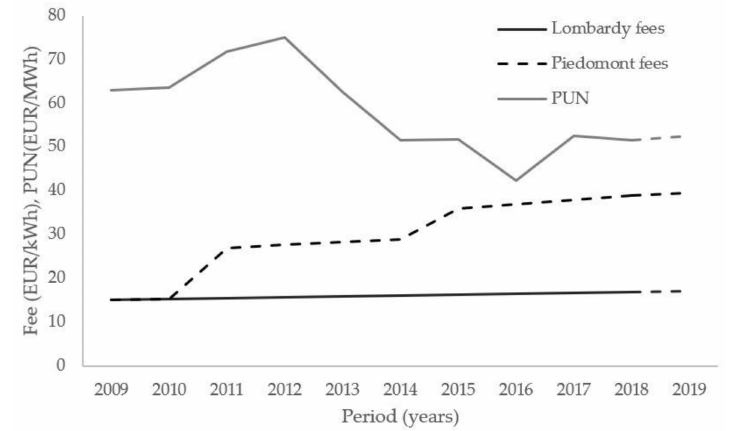
Figure 2. Water concession fees in the period 2009–2019